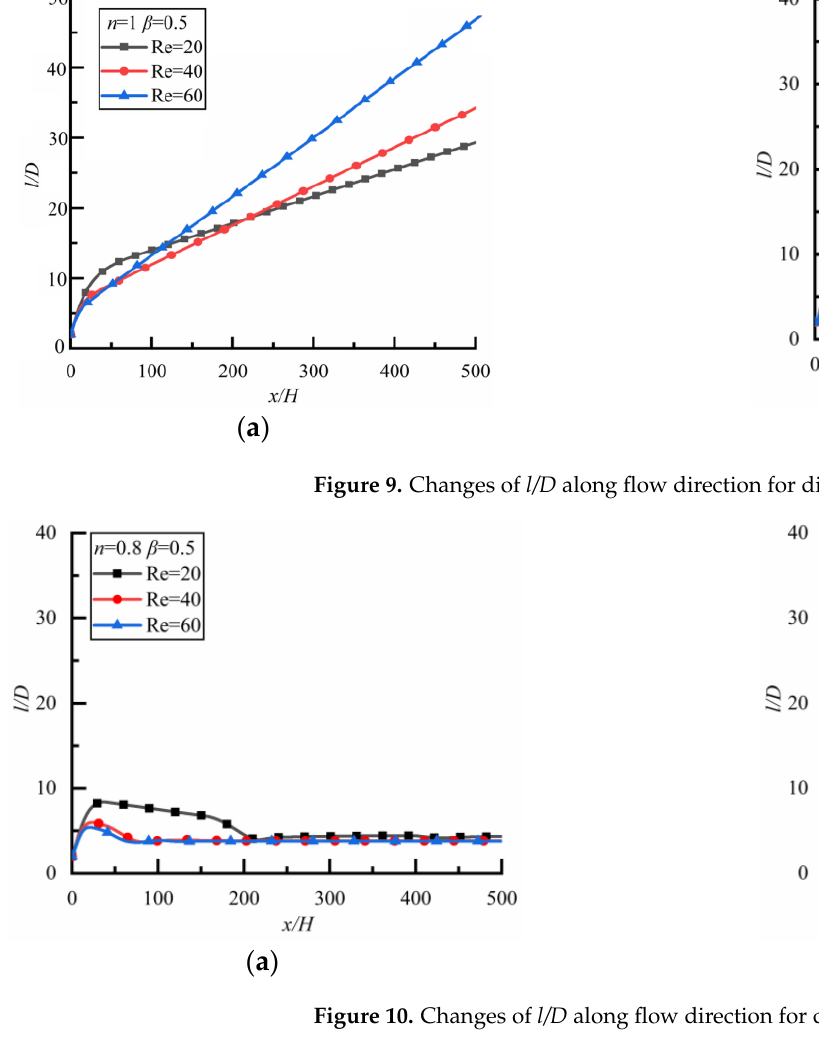
Figure 10. Changes of l/D along flow direction for different Re ( n =0.8). ( a ) β =0.5, ( b ) β =2.